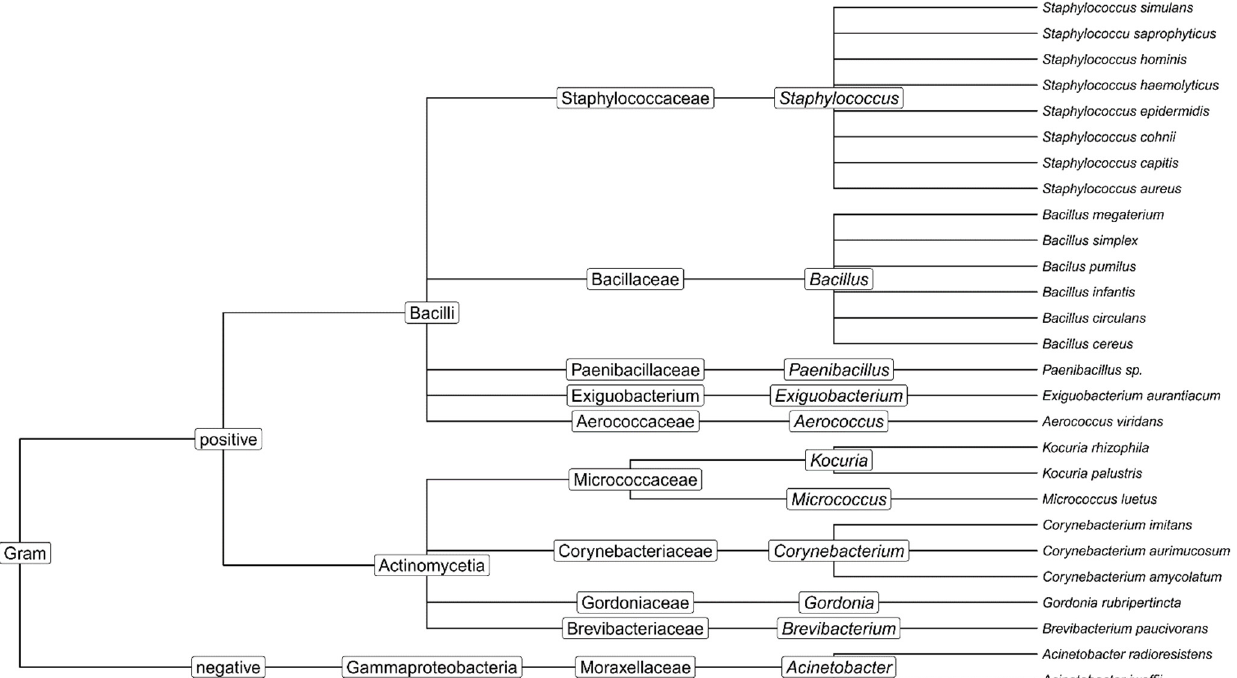
Figure 2. Dendrogram of the cluster analysis results for identified species found across institutions and facilities.